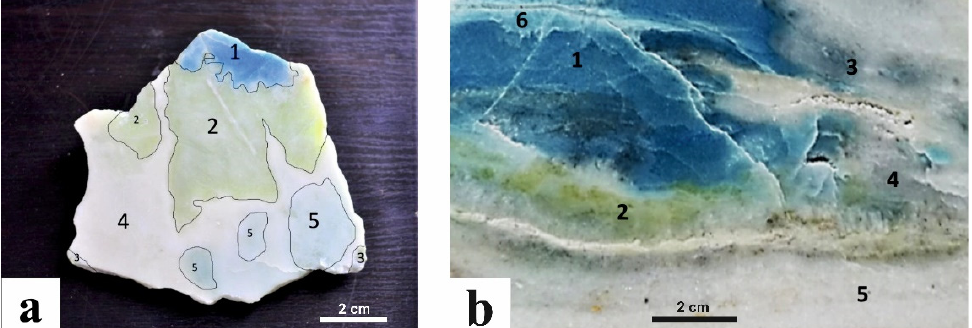
Figure 9. Marble plates used for the XRPD analyses: ( a ) left side, ( b ) right side of the Sissone valley. The different chromatic areas, with variable mineralogical composition, are evident. Table 3. Mineralogical composition of the samples from the areas 1–5 (Figure 9a, b). The semi ‐